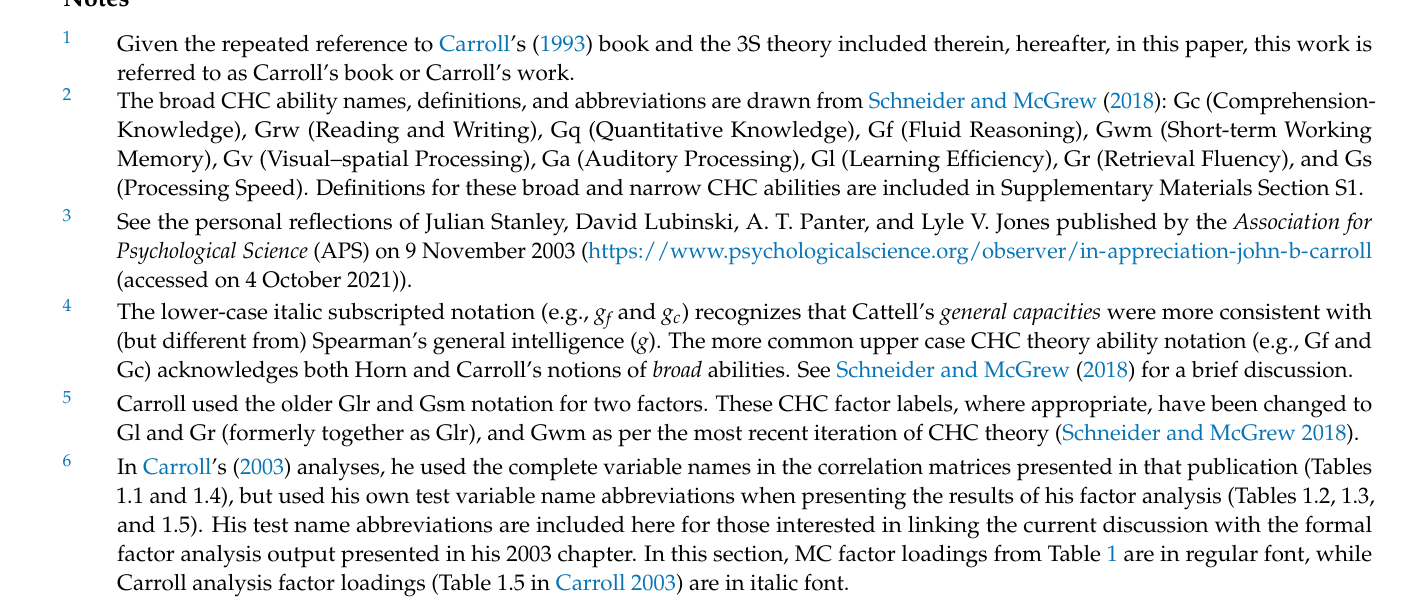
Table S1, Best Available Copy of McGrew–Carroll EFA-SL of 46 WJ III Tests (Completed 5-29-03) Using Carroll’s EFA-SL Software and Methods Described in His 1993 Seminal Book, Table S2, Reorganized, Reformatted and Relabeled Version of Table S1; Section S4, Notes on Completion of WJ III 46-test CFA, Table S3, WJ III 46-test CFA Model Fit Statistics (Model Solution in Table 1 in manuscript); Section S5, Supplementary Hierarchical g and Horn no- g WJ III 46-test CFA, Table S4, WJ III 46-test Table S6, WJ III 46-test Horn CFA no- g Model, Table S7, WJ III 46-test Horn no- g Model (Table S6) Latent Factor Correlations, Table S8, WJ III 46-test Horn no- g CFA Model (Table S6) Fit